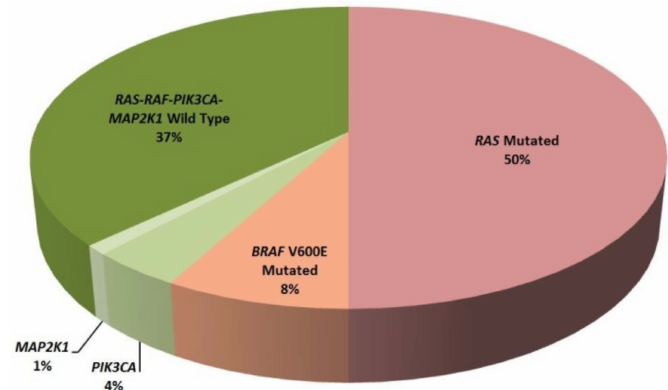
Figure 5. Classification of mCRC patients according to clinically relevant alterations detected by